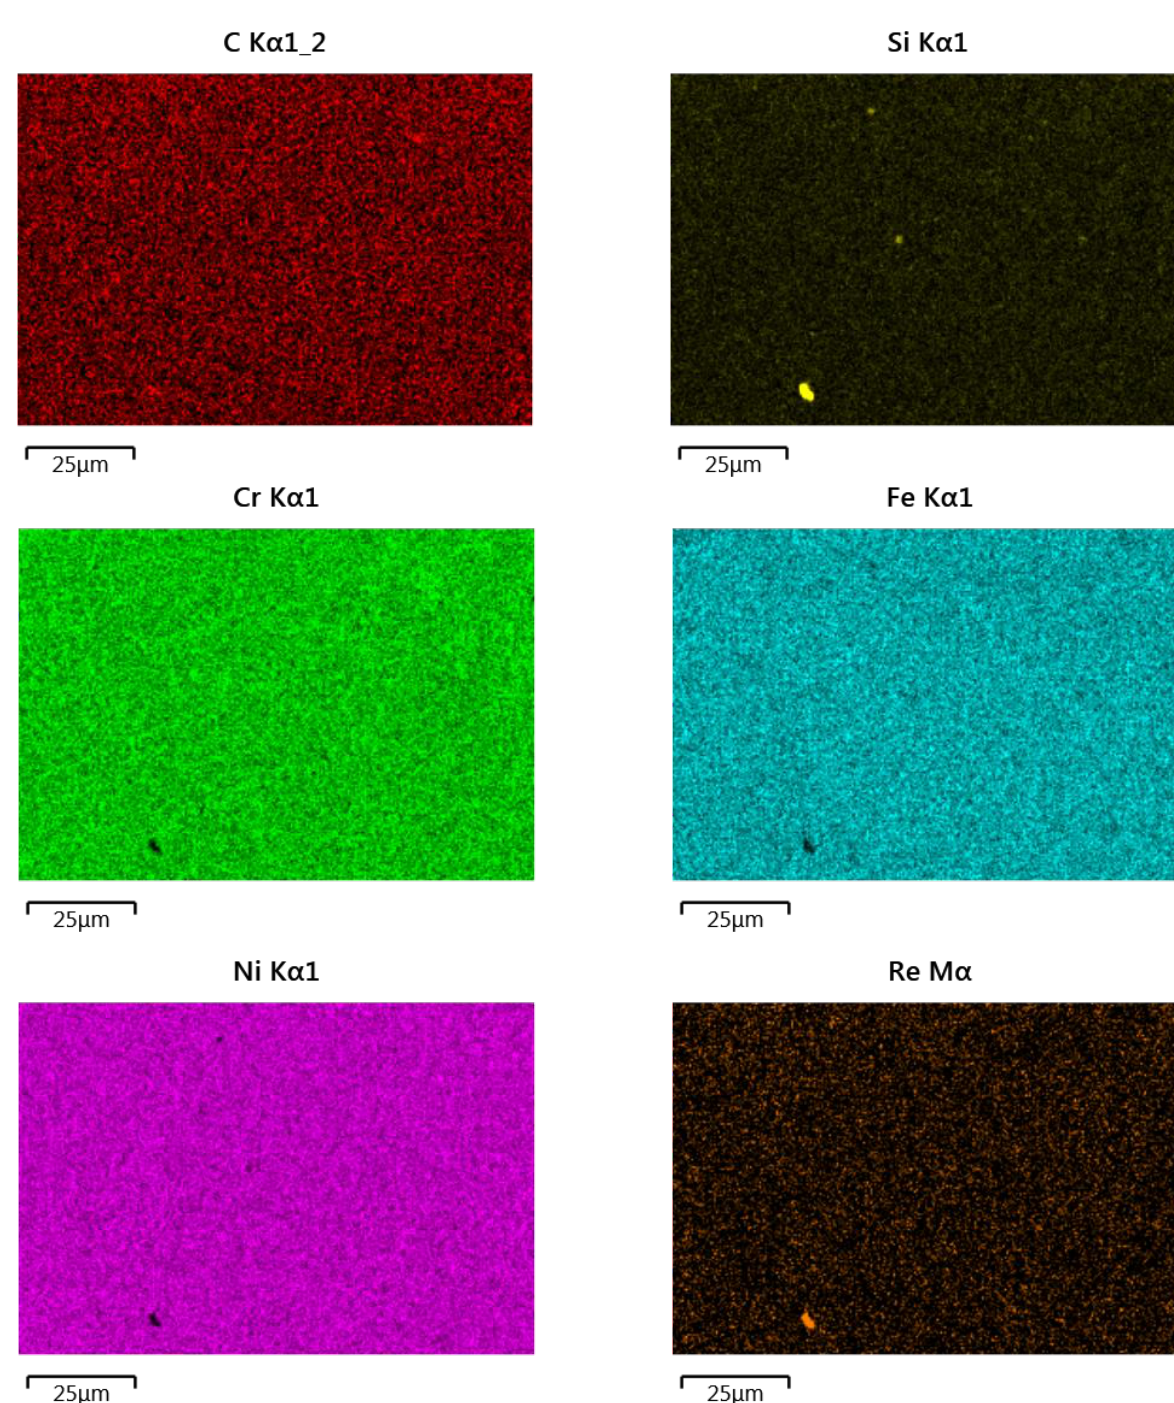
Figure 9. Surface distribution of elements in the laser cladded Ni-20Cr+Re bead at 2400 W laser power.